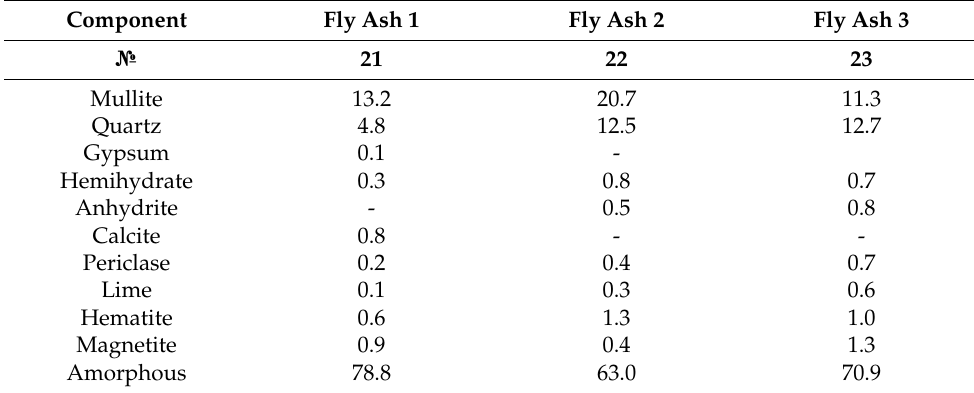
Table 5. Mineralogical composition of the fly ashes (in